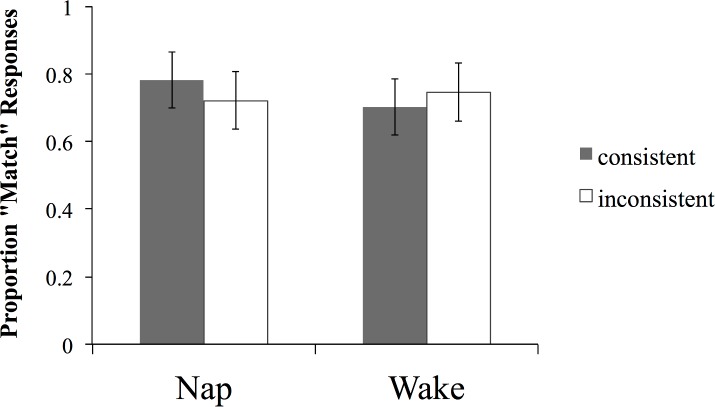
Endorsement rate (proportion of ‘match’ responses) on the word-picture matching task with the Suffix Only generalization set for the two groups.Error bars represent 95% CIs.